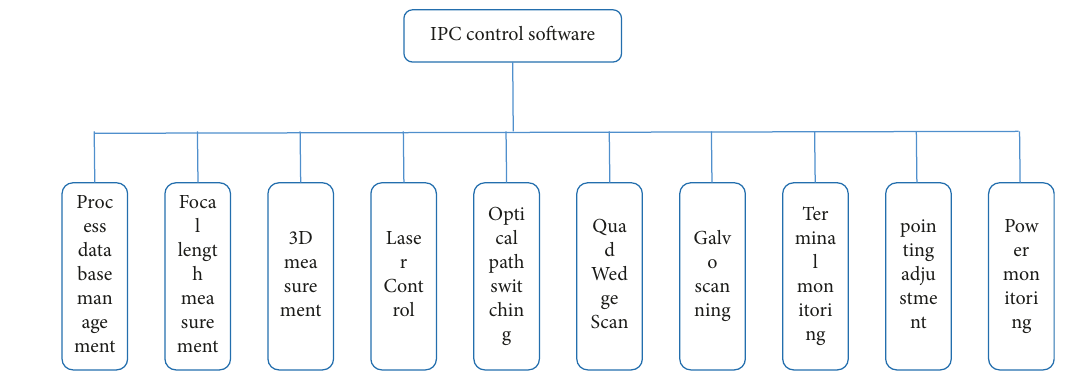
Figure 9: Structure diagram of IPC software module. Table 1: Process database parameter